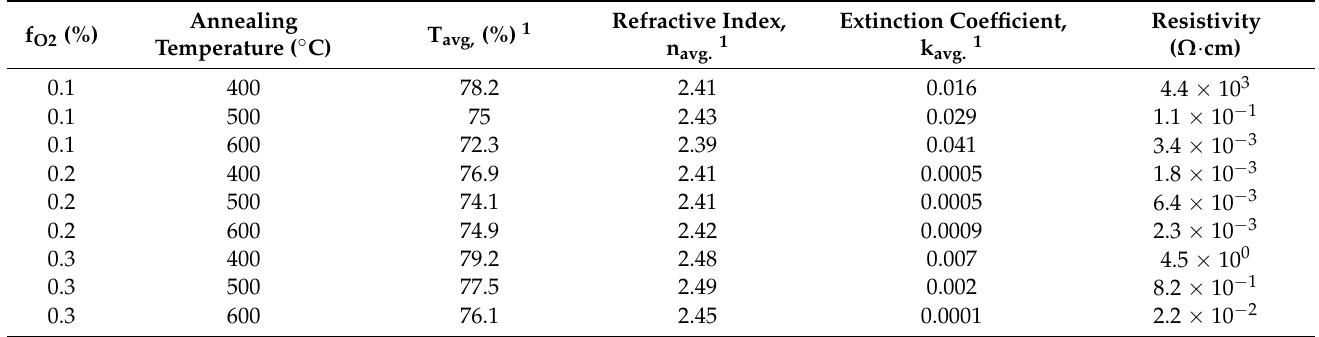
Figure 2. XRD patterns of TNO films ( a ) deposited at various powers with an O 2 ratio of 0.1% and annealed at a temperature of 600 °C, and deposited at a power of 175 W with O 2 ratio at ( b ) 0.1%, ( c ) 0.2% and annealed at various temperatures. RT is the samples as deposited at the room temperature. Table 1. Optical and resistivity properties of TNO films by changing O 2 ratios and annealing temperatures at a fixed deposition power of 175 W.